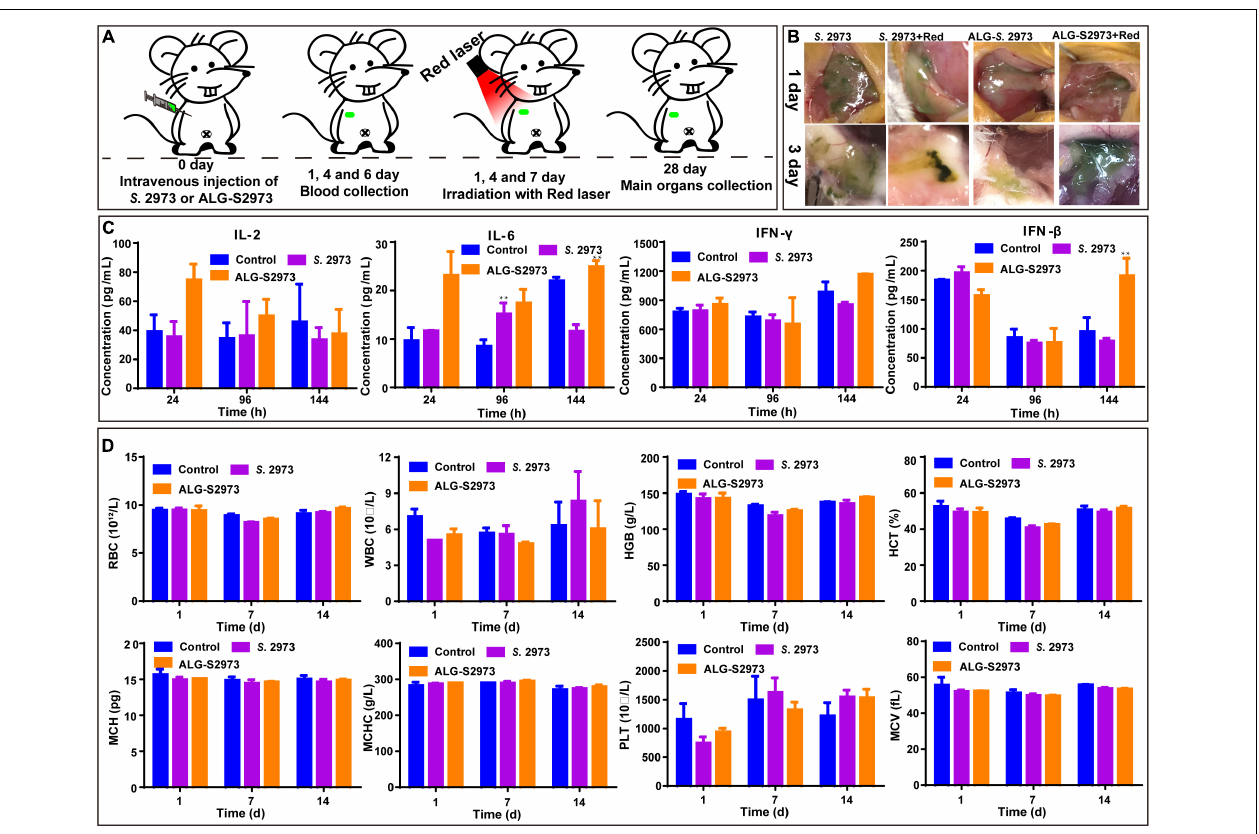
FIGURE 5 | The in vivo long-toxicity evaluation of S . 2973 and ALG-S2973. Each group contained three mice. (A) The schedule of animal experiments for toxicity evaluation. (B) Photos of the injection site of BALB/c mice. (C) Detection of immune factors of mice with different treatments at the 1st, 4th, and 7th day. (D) Hematological index of the mice with different treatments at the 1st, 7th, and 21st day. * p < 0.05, ** p < 0.01 compared with untreated group by Student’s t -test. ALG-S2973, hydrogels packaging S . 2973.